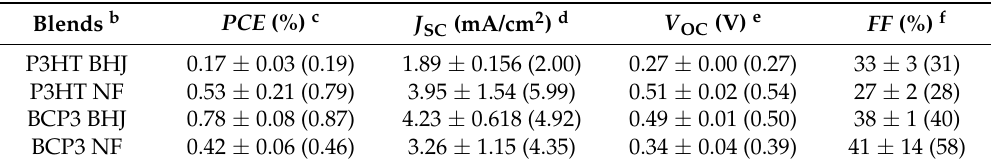
Table 1. Summary of Solar Cell Device Performance Data a